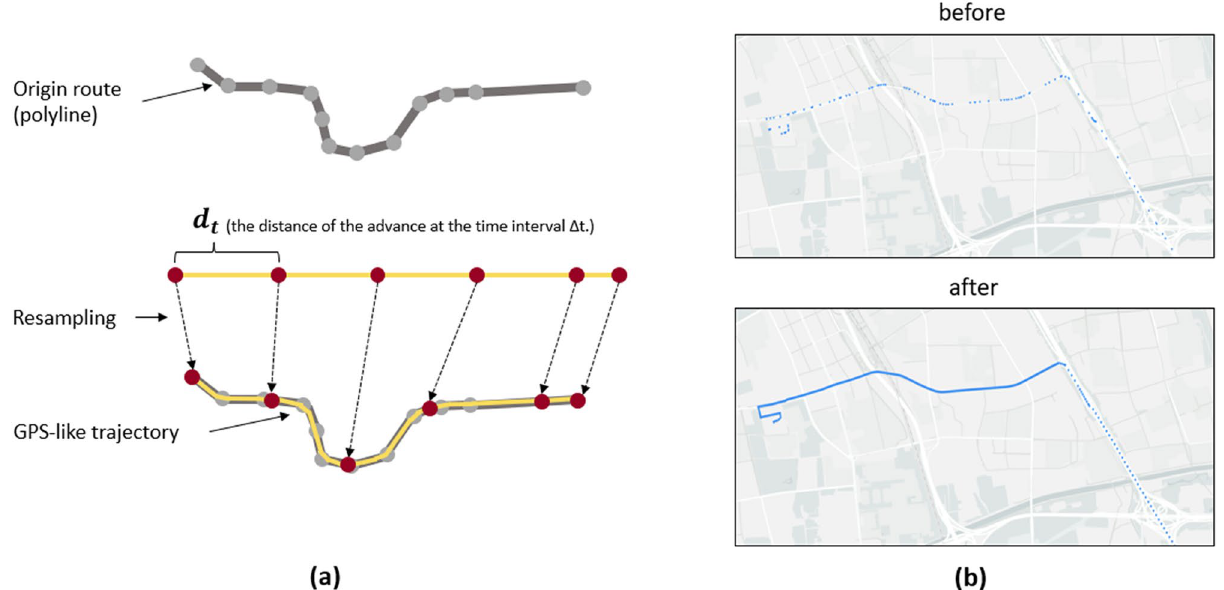
Figure 4. Resampling process ( a ) and the comparison before and after resampling ( b ). ( a ) shows how the original route is resampled. ( b ) before and after compare the effect after resampling (created by Gaode Map JS API, version 2.0, https:// lbs. amap. com/ api/ jsapi- v2/ summa ry). The blue dots represent the data points in the